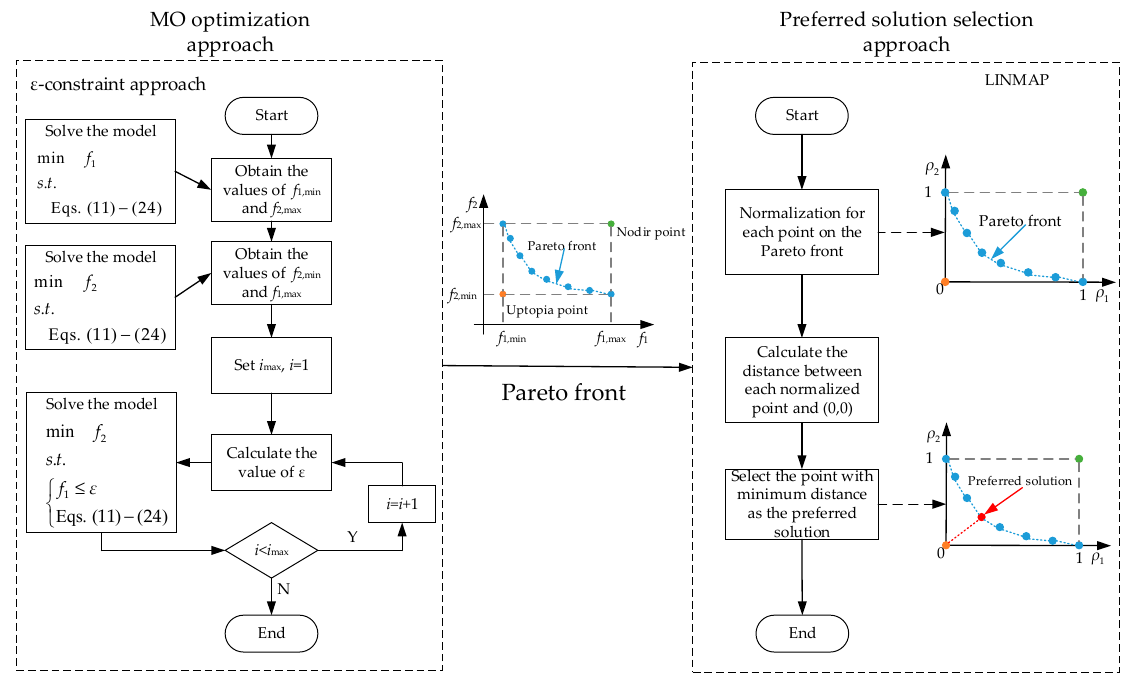
Figure 2. Flowchart of multi-objective (MO) operation strategy.